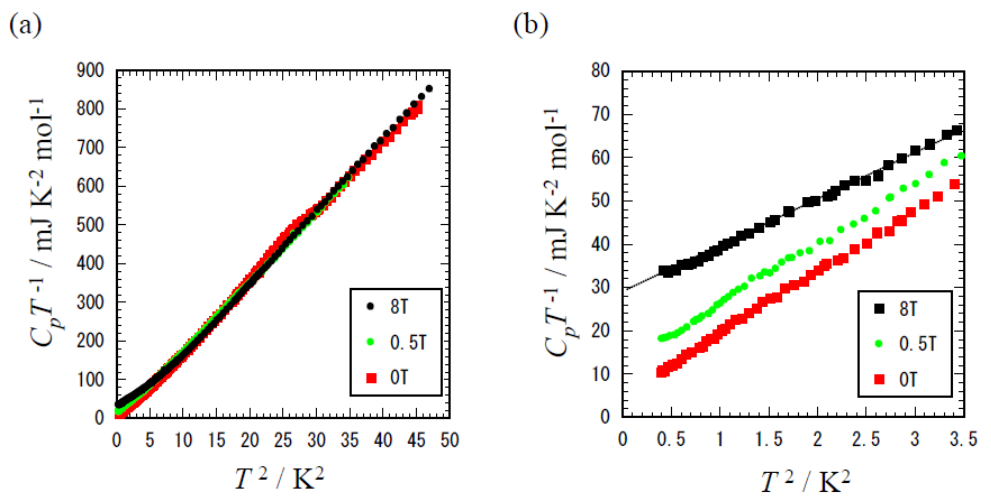
AuI obtained 2 2 T −1 vs . T 2 in the low p